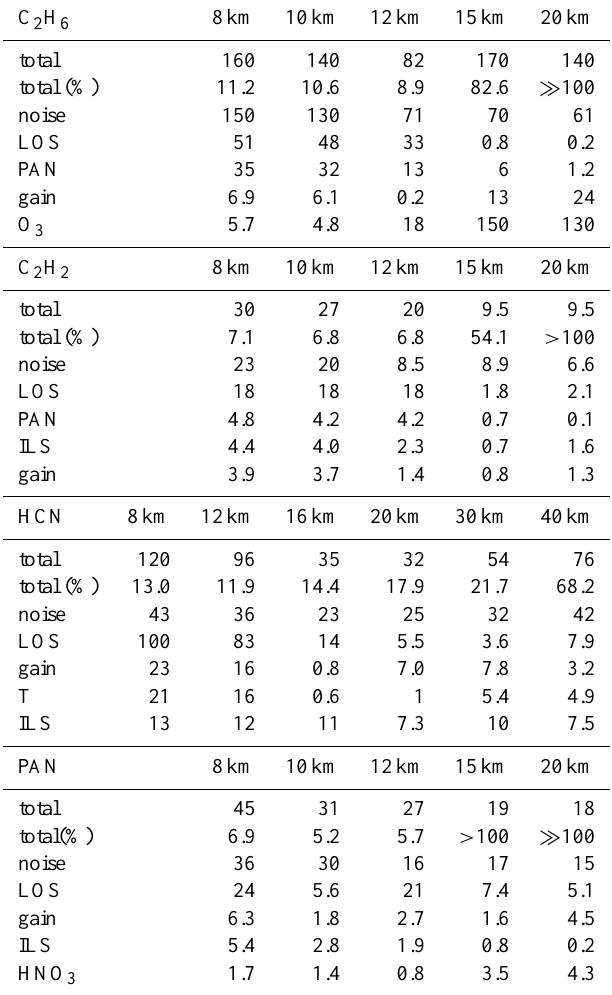
Table 3. Total errors of the retrievals in pptv and percent and the five largest contributing error sources (pptv); LOS=line of sight elevation pointing error; ILS=instrumental line shape uncertainty; gain=radiometric gain calibration error. The errors are calculated for a single biomass burning plume location with enhanced mixing ratios of all